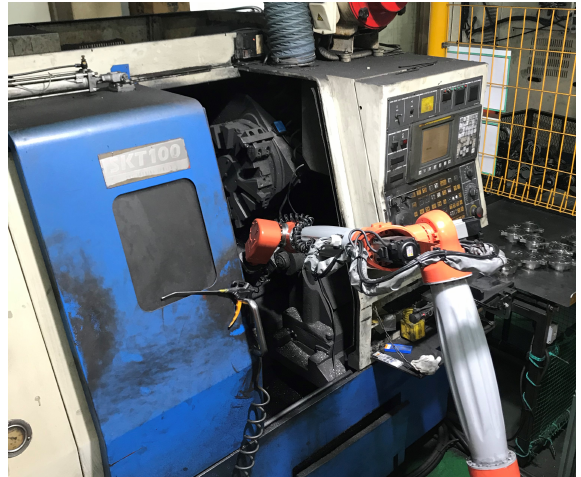
Figure 1. On-site inspection of the CNC